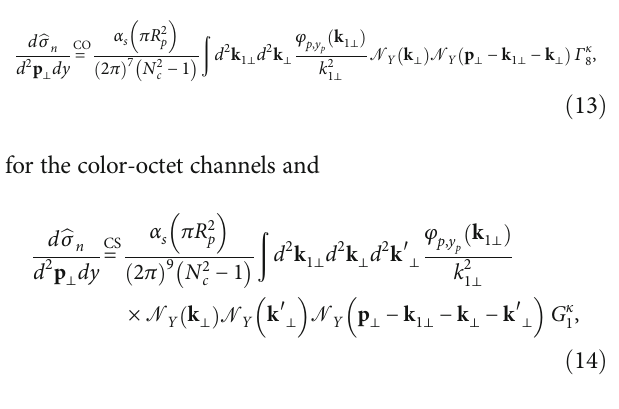
Figure 6: The angular distribution coe ffi cients λ Ref.